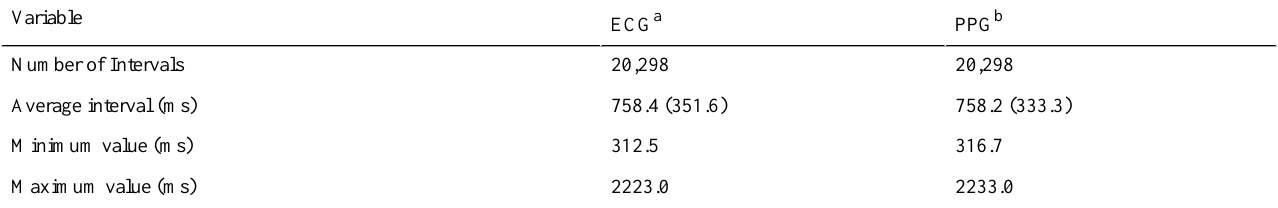
Table 5. Overview study results.